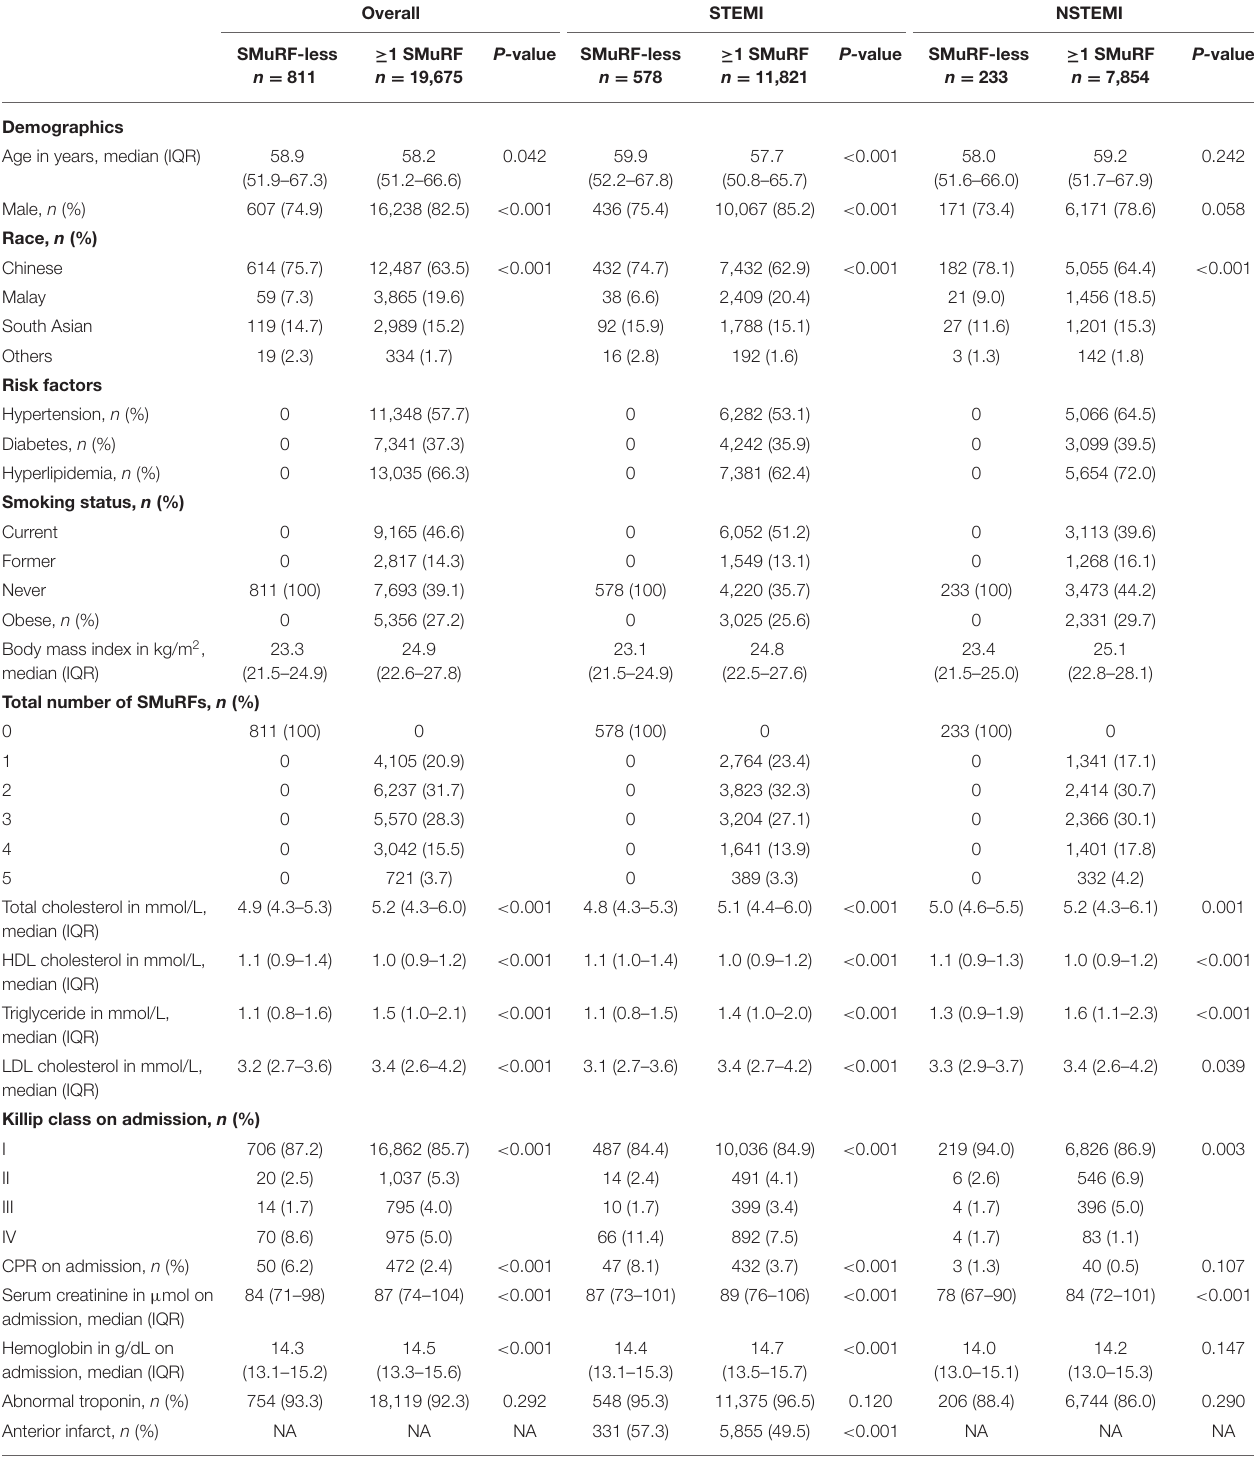
TABLE 1 | Baseline characteristics of STEMI and NSTEMI patients with respect to SMuRF (including obesity) ( n = 20,476).